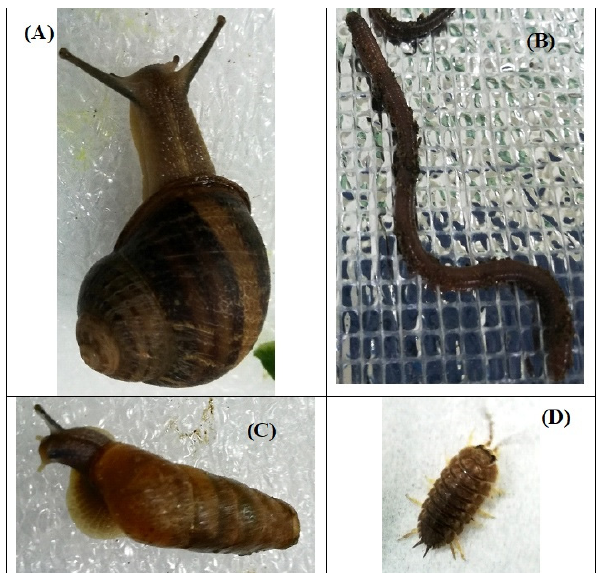
Figure 2. Representative photos of the collected terrestrial samples: ( A ) E. vermiculata (helix), ( B ) Lumbricus terrestris (earthworm), ( C ) R. decollata (decollate), and ( D ) Porcellio (woodlice).